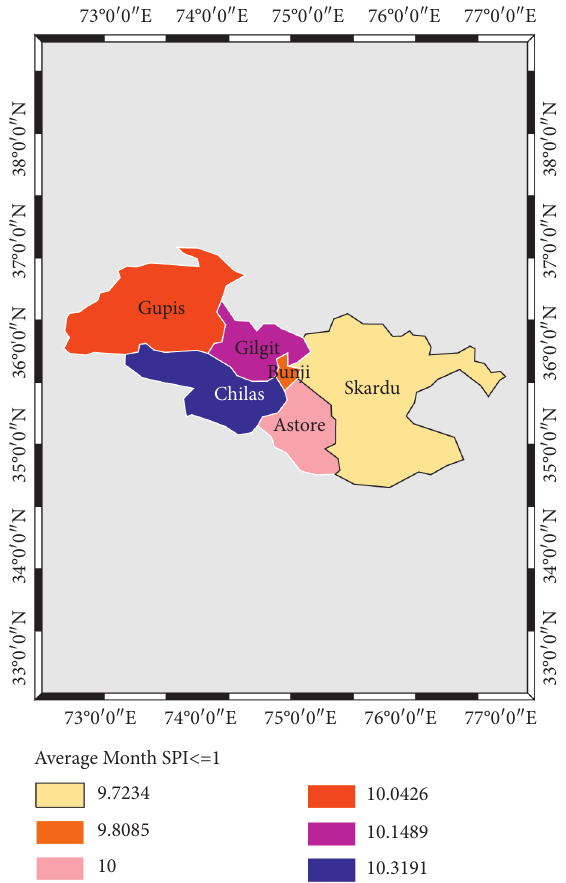
Figure 6: The latitude and longitude of the selected stations and their monthly averages for SPI ≤